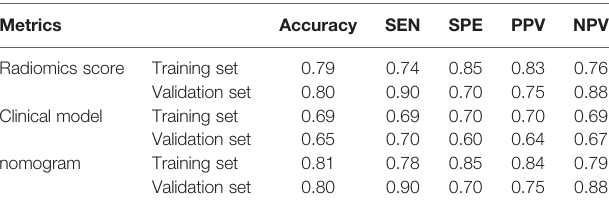
TABLE 3 | Predictive performances of the three